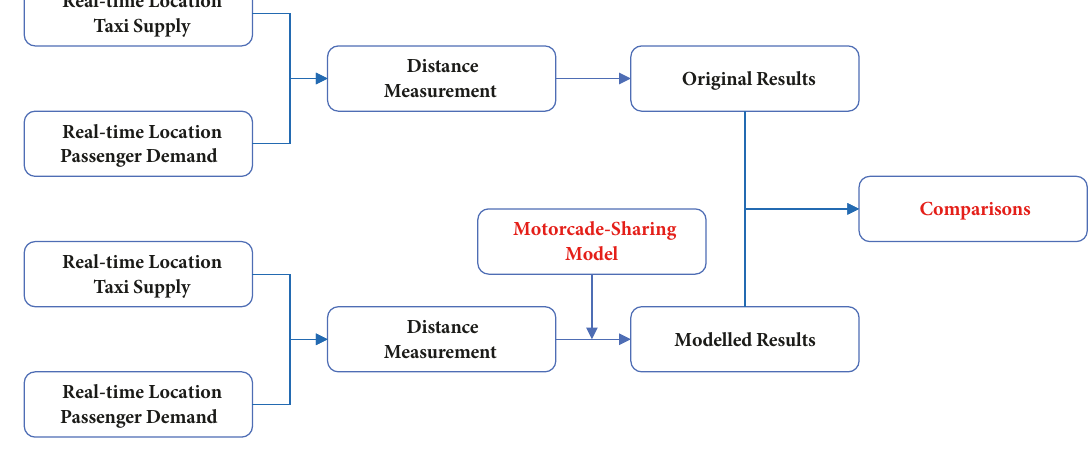
Figure 1: Measurement steps